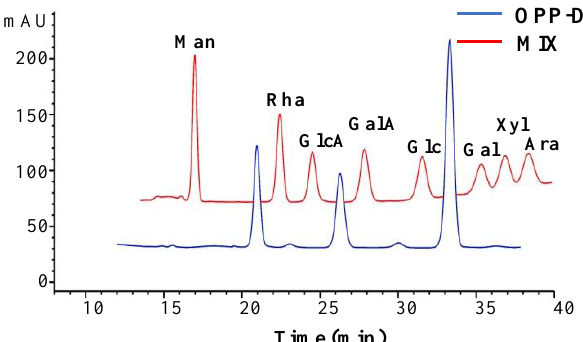
Figure 1. High-performance liquid chromatography profile of purified okra polysaccharides (OPP-D). Man, mannose; Rha, rhamnose; GlcA, glucuronic acid; GalA, galacturonic acid; Glc, glucose; Gal, galactose; Xyl, xylose; Ara, arabinose.